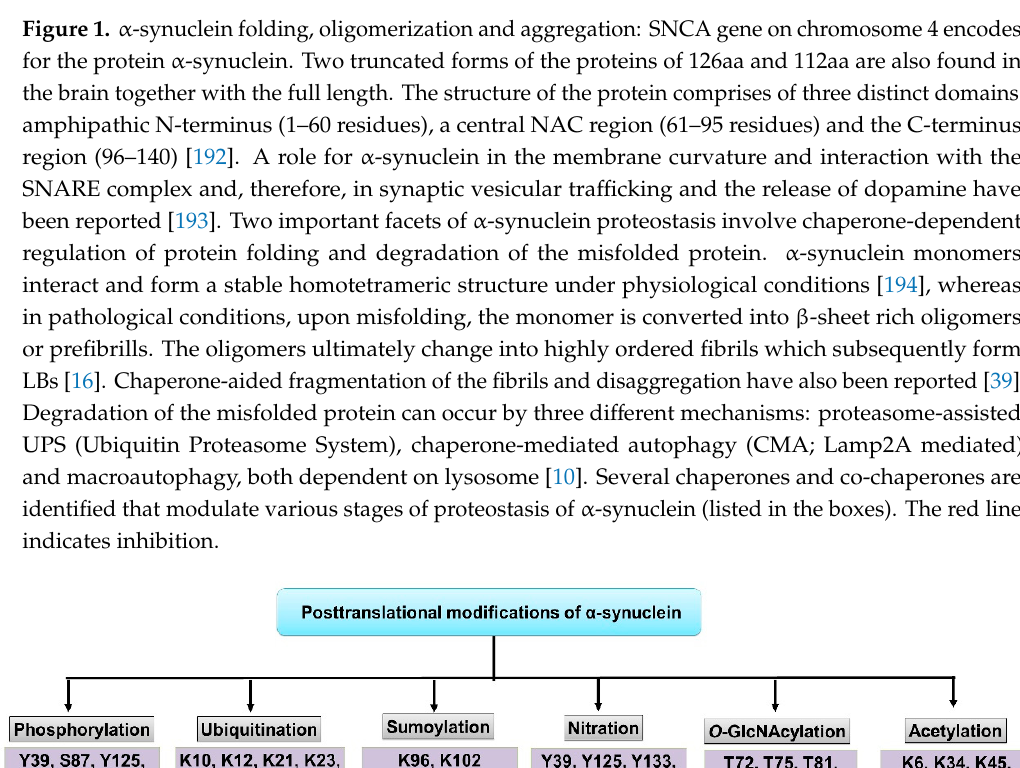
Figure 2. Posttranslational modifications identified that regulate α -synuclein function: Several posttranscriptional modifications (PTMs) have been reported that regulate proteostasis of α -synuclein such as phosphorylation, ubiquitination, sumoylation, nitration, acetylation and O -GlcNAcylation. α -synuclein is reported to be phosphorylated at serine (S129 and S87) [195] and tyrosine (Y125, Y133 and Y135) residues [196]. α -synuclein associated with Lewy bodies (LBs) is majorly phosphorylated at S129 [197]. Phosphorylation is catalyzed by several kinases such as Casein kinases (CKs), Polo-like kinases (PLKs) and G-protein coupled receptor kinases (GRKs) [25]. α -synuclein is ubiquitinated by the E3 ubiquitin-protein ligases like C-terminus of Hsp70 Interacting Protein (CHIP), Seven In Absentia Homologue (SIAH) and Nedd4 at various residues that either increase or stop the aggregation of the protein [198]. SUMOylation (SUMO: small ubiquitin-like modifier) of α -synuclein at residues K96 and K102 by PIAS2 that reduces oligomerization and aggregation was reported [199]. Nitration of tyrosine residues Y39, Y125, Y133 and Y136 results in increased oligomerization and aggregation of the protein [200,201], Enhanced fibrillization was also reported upon nitration of Y39 [202]. O -GlcNAcylation on the other hand inhibits toxicity caused by extracellular α -synuclein aggregates [203,204]. α -synuclein under physiological conditions is reported to undergo N-terminal acetylation. This modification most likely keeps the protein in its native form and prevents / reduces aggregation. K6, K34, K45 and K96 are reported to undergo acetylation [205]. Several of these PTMs may influence toxicity and aggregation of the protein. α -synuclein may also have several of the abovementioned PTMs at a given time in vivo. ↑ —increase, ↓ —decrease and ×— stops.